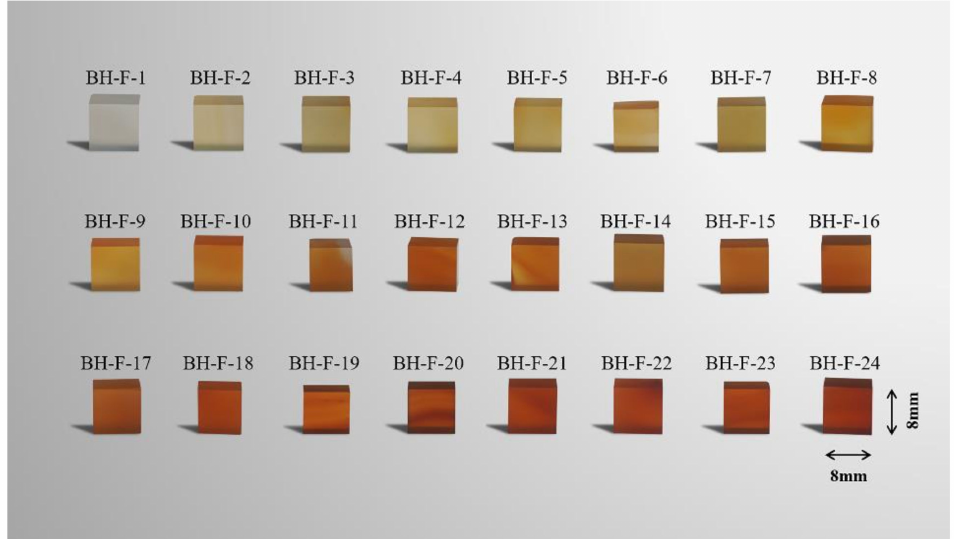
Figure 1. Photograph of the samples used in the present study. The sample named BH-F-1 in the upper left corner is a nearly colourless control